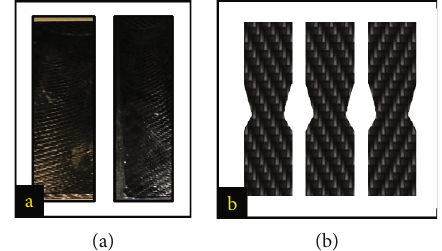
Figure 2: Photographic image of (a) tensile specimen and (b) impact specimen.